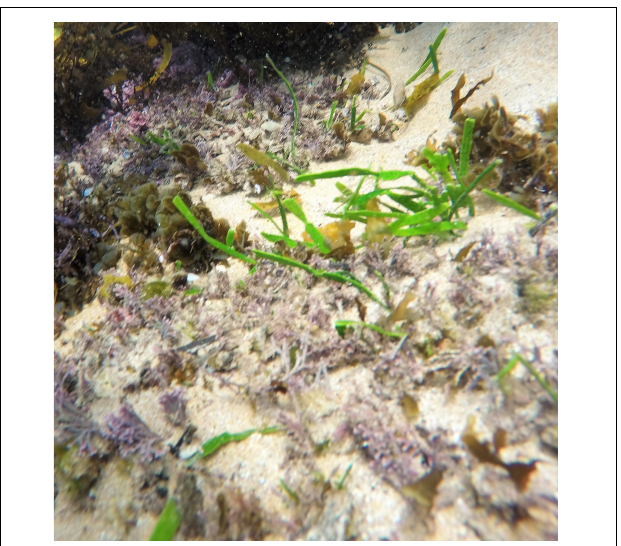
FIGURE 2 | Multiple Caulerpa filiformis recruits within coralline turf habitat. Image width ∼ 40 cm.